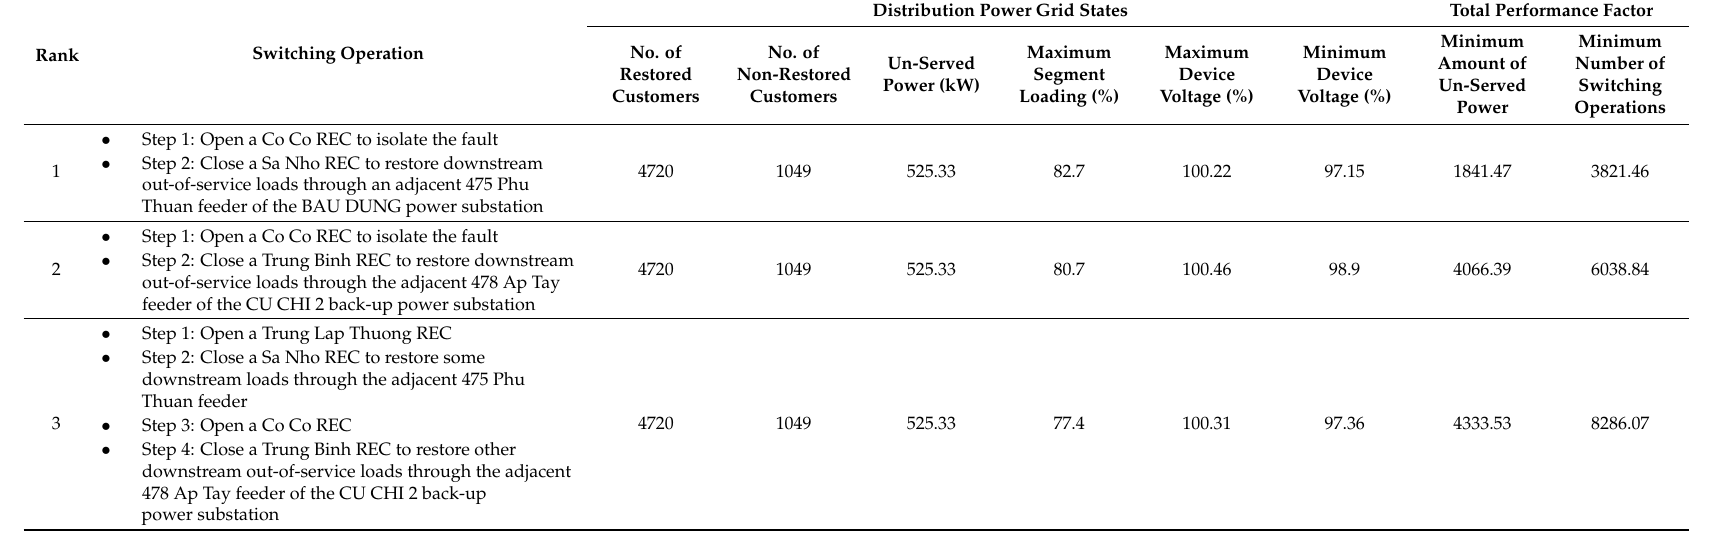
Table 13. Possible fault isolation and service restoration plans based on two proposed constraints (with the SPGF at F1).